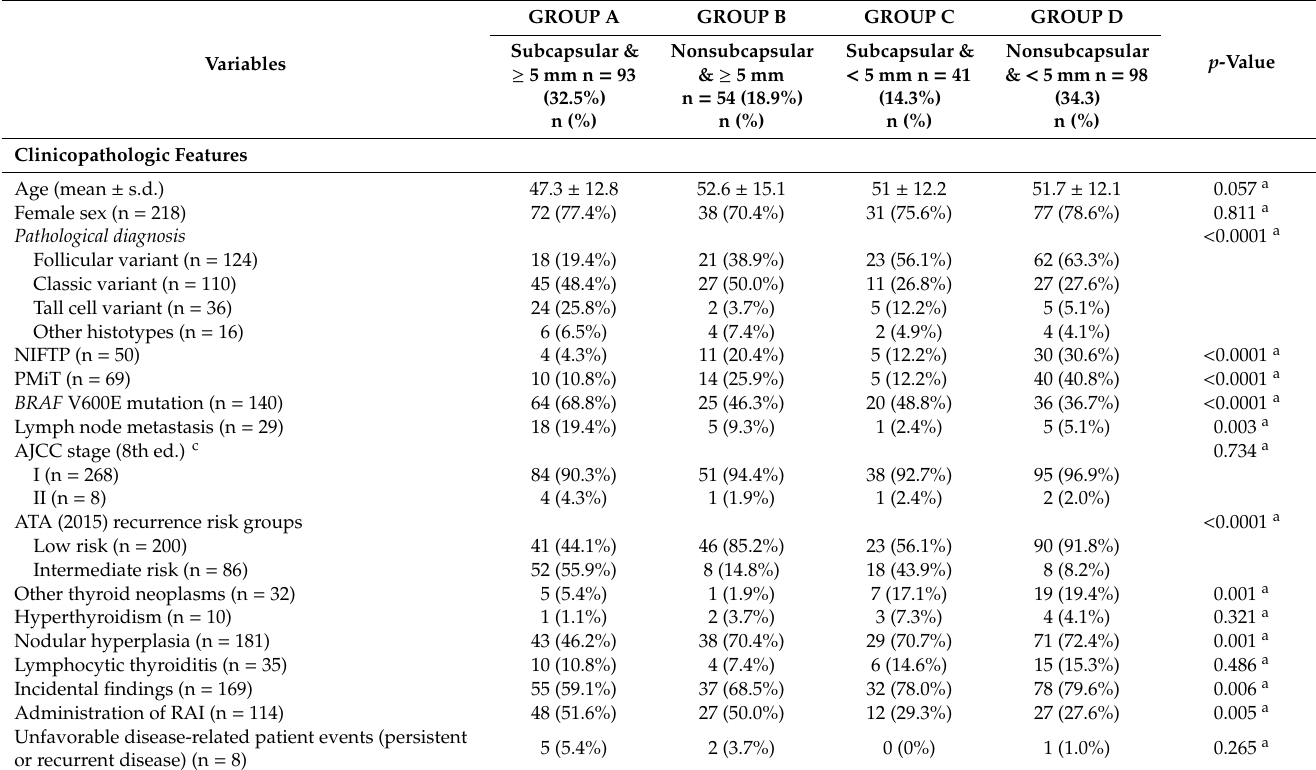
Table 2. Univariate analysis comparing the four microcarcinoma groups (Total: 286